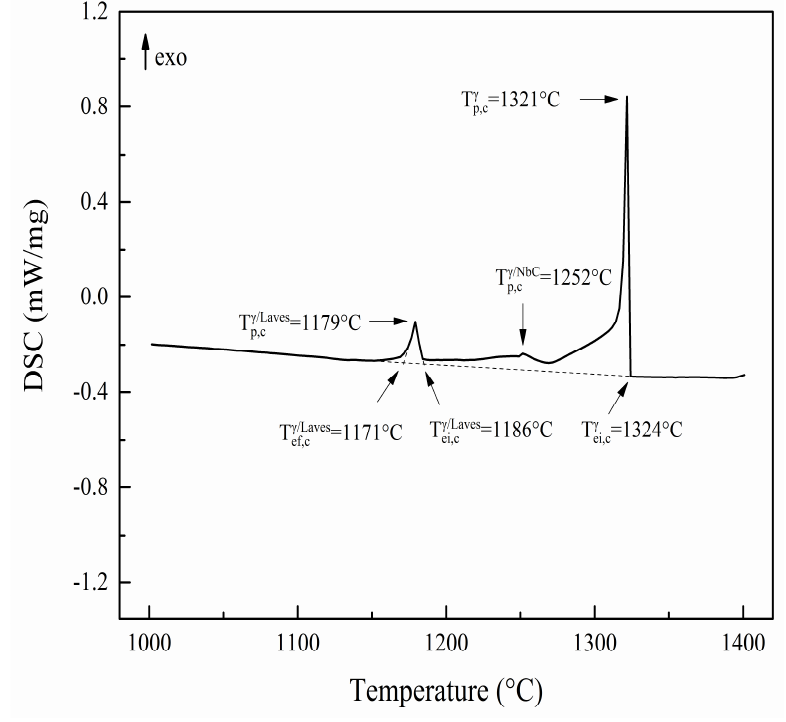
Figure 1. DSC curve and reaction temperatures of experimental IN718 specimen.